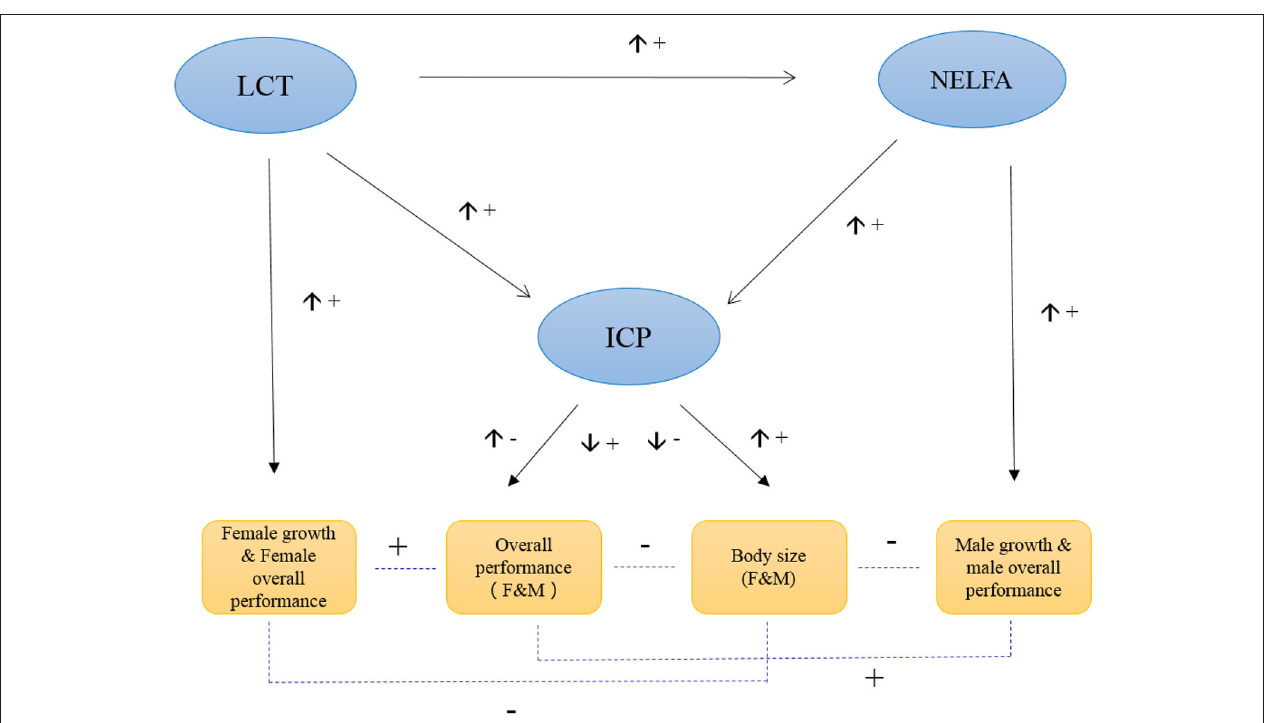
FIGURE 5 | Hypothesized model of the molecular control of grasshopper phenotypic plasticity. The up arrow ( ↑ ) beside the connecting line indicates the expression of the upstream gene is increasing, while down arrow ( ↓ ) indicates the expression of upstream gene is decreasing. “ + ” indicates the positive effect, while “ − ” indicates the negative